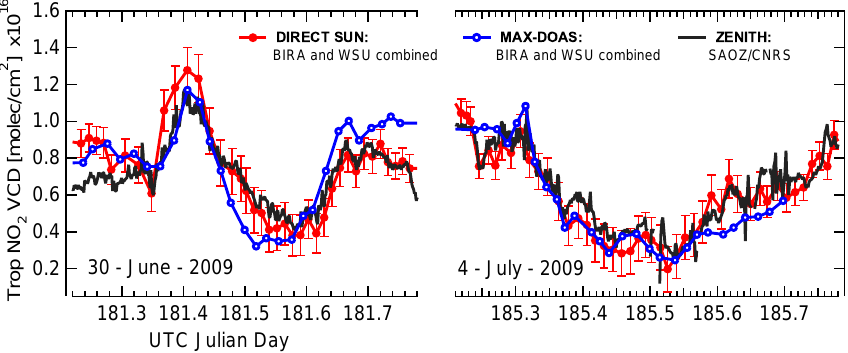
Fig. 14. Tropospheric NO 2 columns derived from direct-sun (red) and MAX-DOAS (blue) measurements from the BIRA-IASB and WSU MAX-DOAS instruments, and from zenith-sky measurements (black) from the CNRS/SAOZ instrument, on 30 June and 4 July 2009. The measurements from BIRA-IASB and WSU were averaged for data points within 10min of each